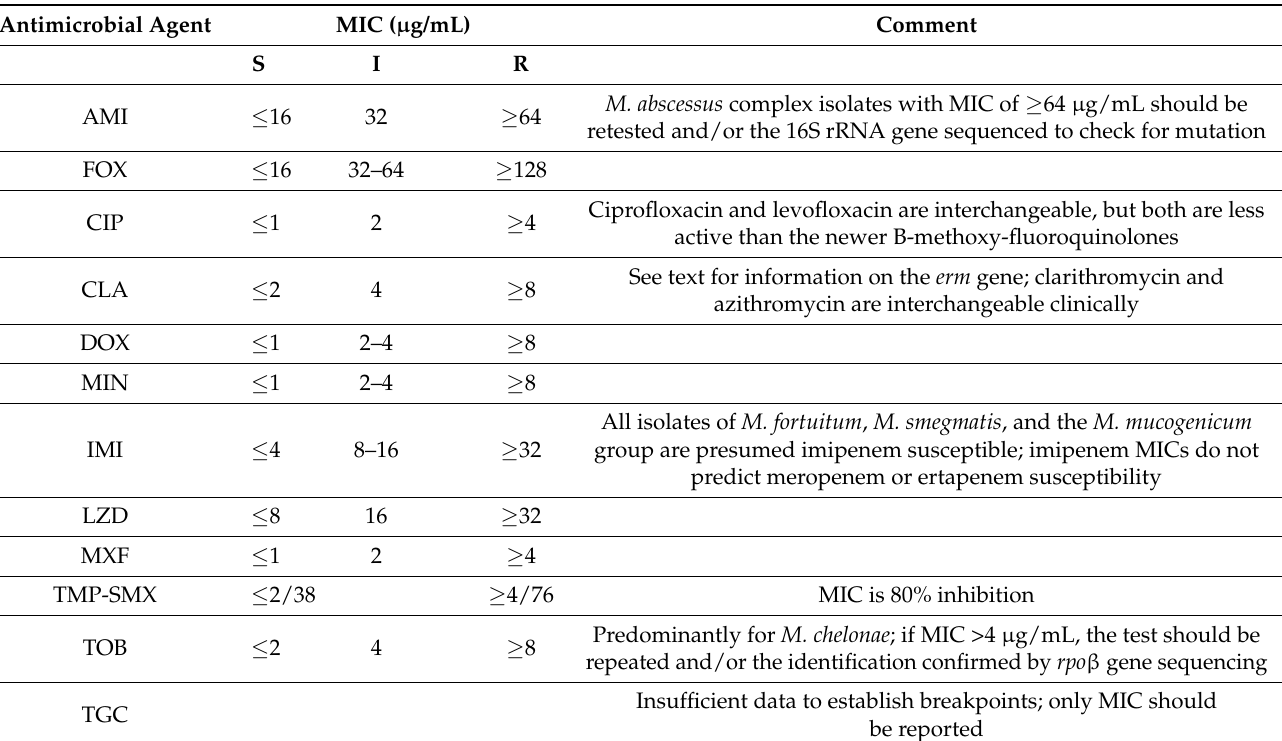
Figure 1. RAPMYCOI plate design: positive control (POS), amikacin (AMI), amoxicillin/clavulanic acid (AUG2), cefepime (FEP), cefoxitin (FOX), ceftriaxone (AXO), ciprofloxacin (CIP), clarithromycin (CLA), doxycycline (DOX), imipenem (IMI), linezolid (LZD), minocycline (MIN), moxifloxacin (MXF), trimethoprim/sulfamethoxazole (SXT), tigecycline (TGC), and tobramycin (TOB). The number under the antibiotic abbreviation shows its concentration in µ g/mL. Table 3. Antimicrobial agents and susceptibility breakpoints (MICs) for testing rapidly growing